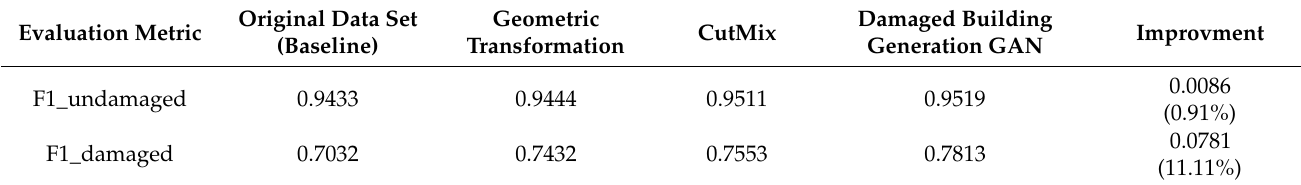
Table 9. Effect of data augmentation by damaged building generation